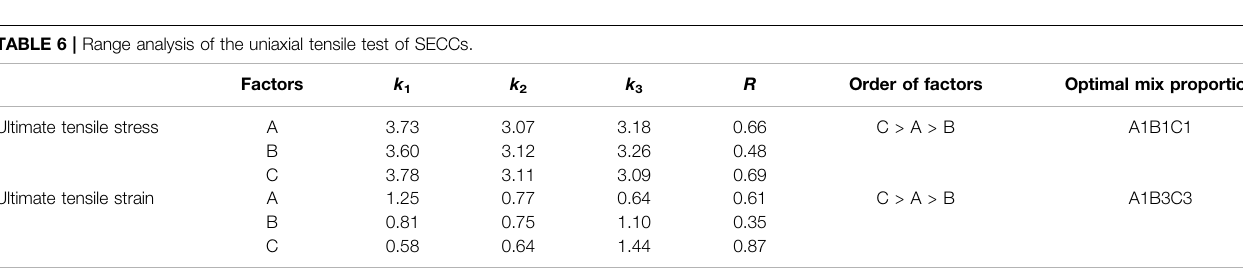
TABLE 6 | Range analysis of the uniaxial tensile test of